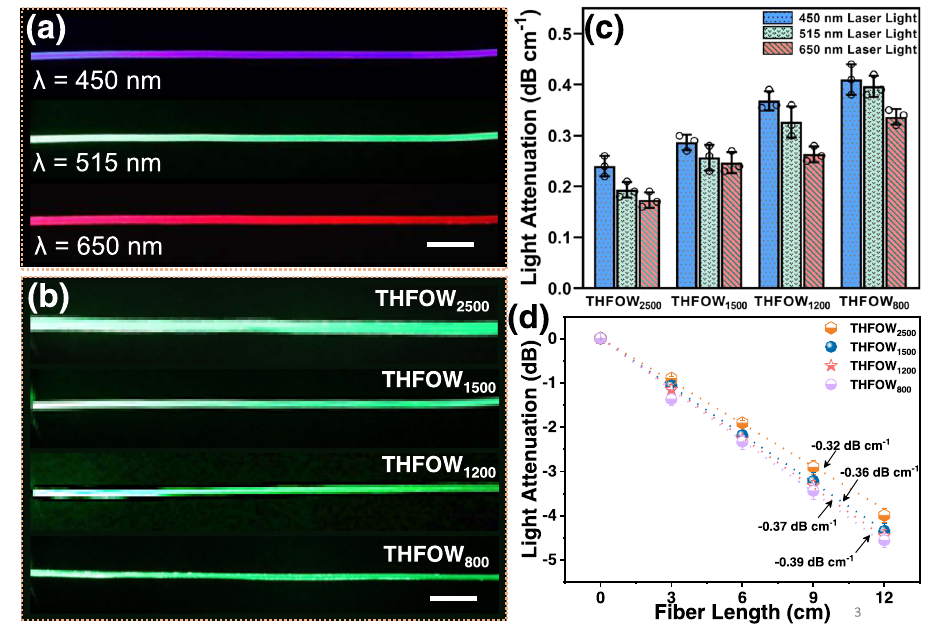
Fig. 3 | Light propagation through the THFOW. a Laser light with different wavelength ( λ =450, 515 and 650nm) propagate through the THFOW; ( b ) Laser lightpropagatesthroughTHFOWswithdifferentdiameters;( c )Lightattenuationof the THFOW calculated from the scattered light intensity along with the THFOW